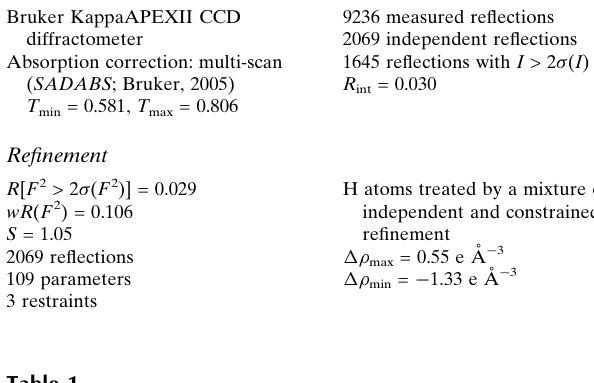
Hydrogen-bond geometry (A˚ , (cid:1)